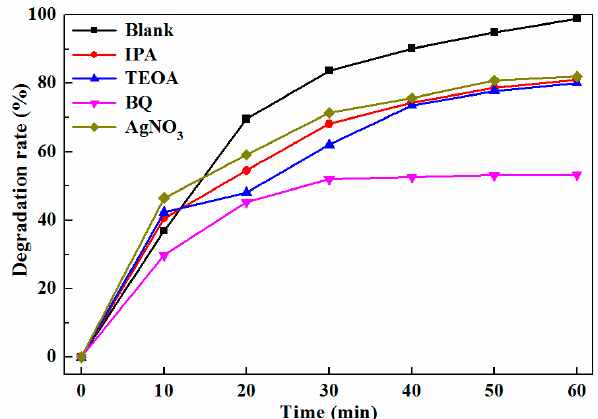
Figure 10. Photocatalytic degradation rate of TC for Sr 2 TiO 4 :N,Nb(2%) in the presence of different scavengers.